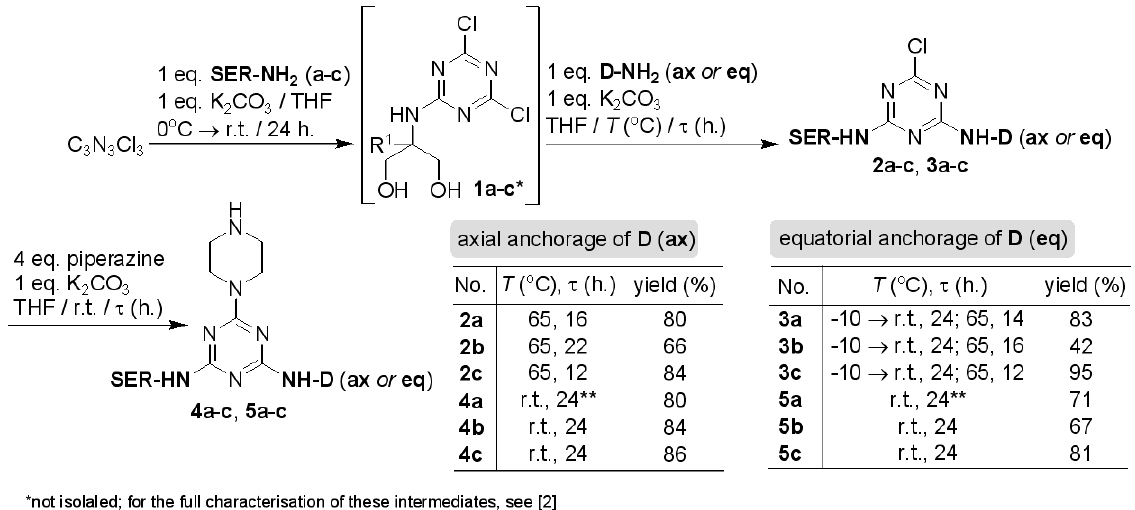
Scheme 3. Synthesis of targeted N -substituted